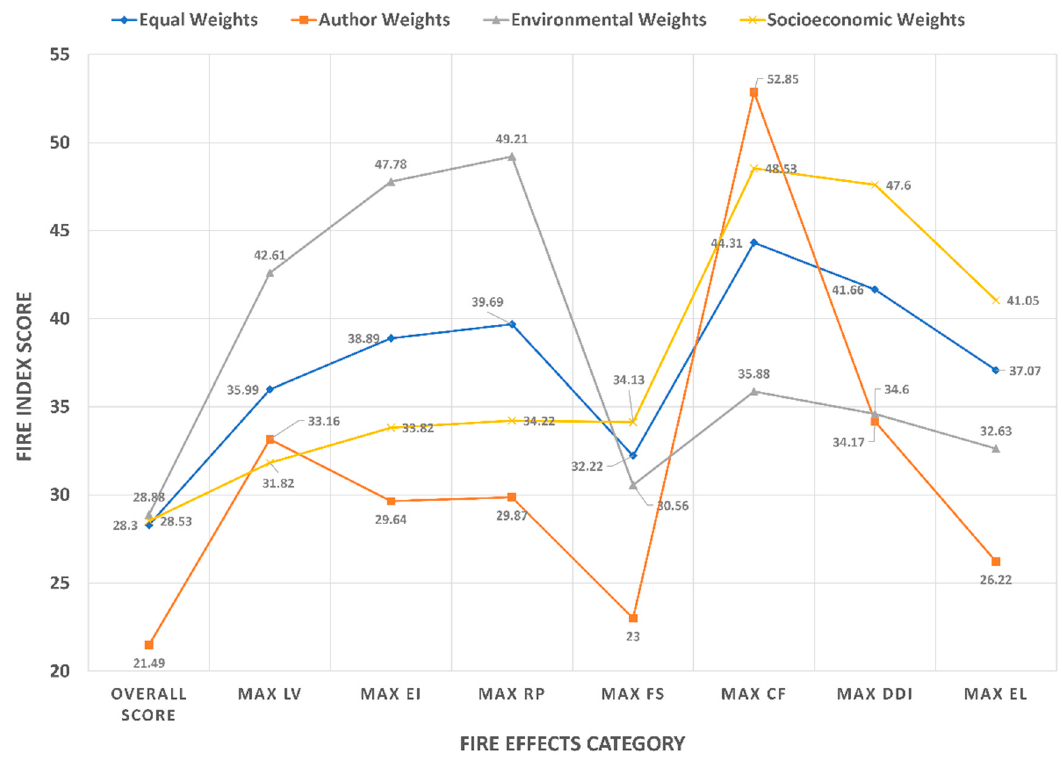
Figure 4. Fire Inventory and Ranking of E ff ects (FIRE) Index scores as derived from sensitivity analysis on the four alternative weight assignment scenarios on the Evros fire. In the overall score column, we used the values of each fire e ff ects category as derived from the evaluation of the Evros fire in Appendix C. The four lines show the FIRE Index score after changing category weights based on the four scenarios. The Max columns show the final FIRE Index score after maximizing one at a time, and the value of each fire e ff ects category while keeping all other category scores constant. LV: landscape and vegetation; EI: environmental impacts; RP: regeneration potential; FS: firefighting and suppression; CF: casualties and fatalities; DDI: destruction and damages of infrastructure; EL: economic losses.